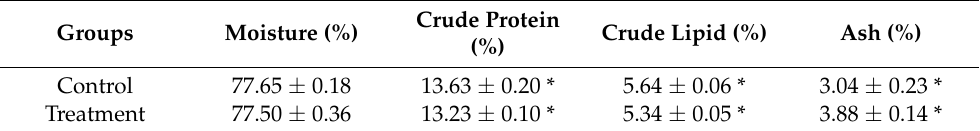
Table 4. Comparison of whole-body composition in A. schrenckii .